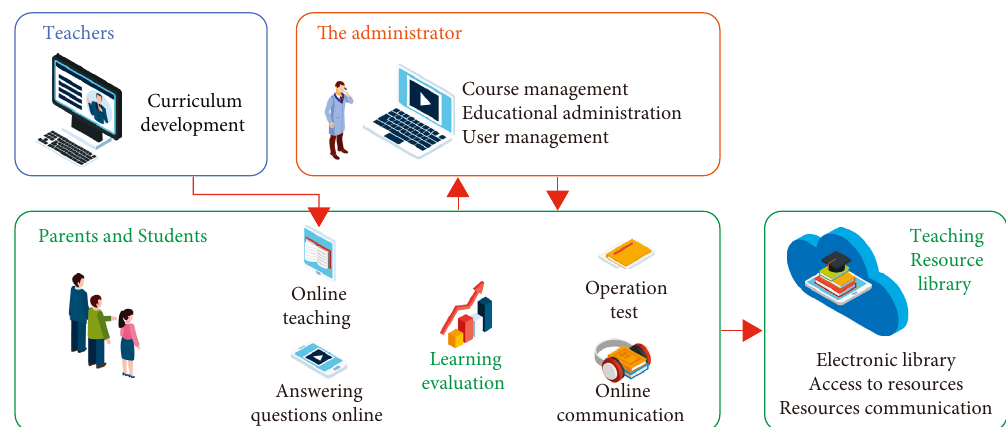
Figure 1: Network-assisted instruction